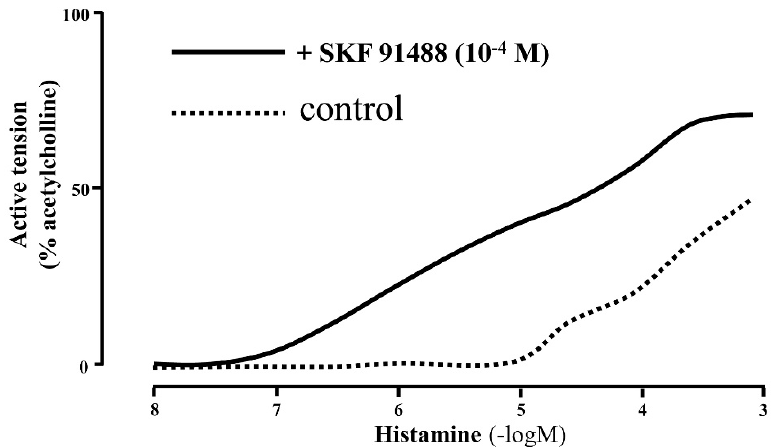
Figure 2. The effects of terfenadine on bronchoconstriction induced by ( A ) Histamine and ( B ) Allergen. Terfenadine (dotted curve) significantly attenuated bronchoconstriction induced by allergic challenge. (Solid curves indicate pretreatment with terfenadine. Dotted curves indicate pretreatment with placebo. The figure was modified from reference [16] with permission: Rafferty et al., The contribution of histamine to immediate bronchoconstriction provoked by inhaled allergen and adenosine 5’ monophosphate in atopic asthma. Am. Rev. Respir. Dis. 1987, 13, 369–373.